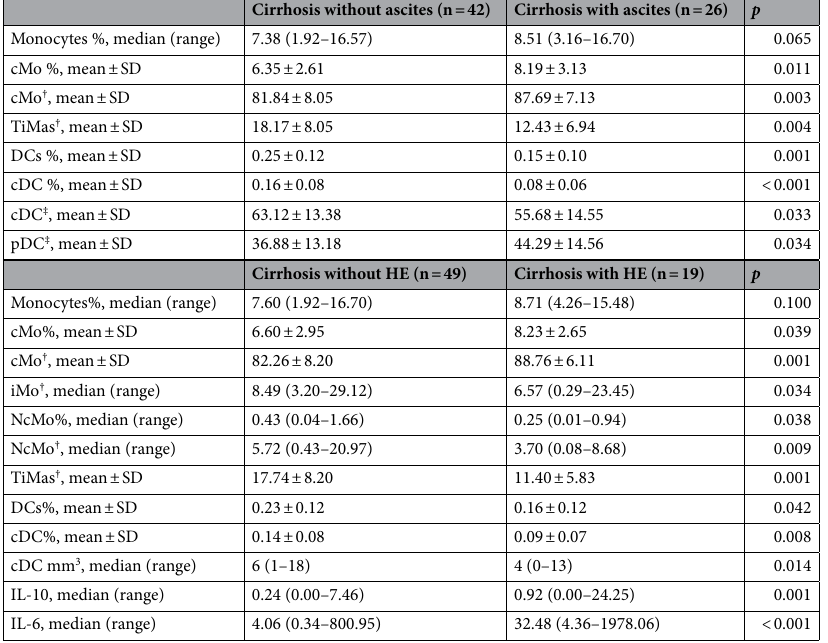
Table 2. Monocytes and DCs in cirrhotic patients in relation to the presence of ascites and hepatic encephalopathy. cDC Classical dendritic cell, cMo Classical monocytes, DCs Dendritic cells, HE Hepatic encephalopathy, IL Interleukine, iMo Intermediate monocytes, ncMo Nonclassical monocytes, pDC Plasmacytoid dendritic cell, TiMas Tissular macrophages. † The percentage of monocytes subsets referred to as total monocytes. ‡ The percentage of cDC and pDC referred to as total DCs. Statistical differences between groups were calculated using Mann–Whitney U and Student’s T-test